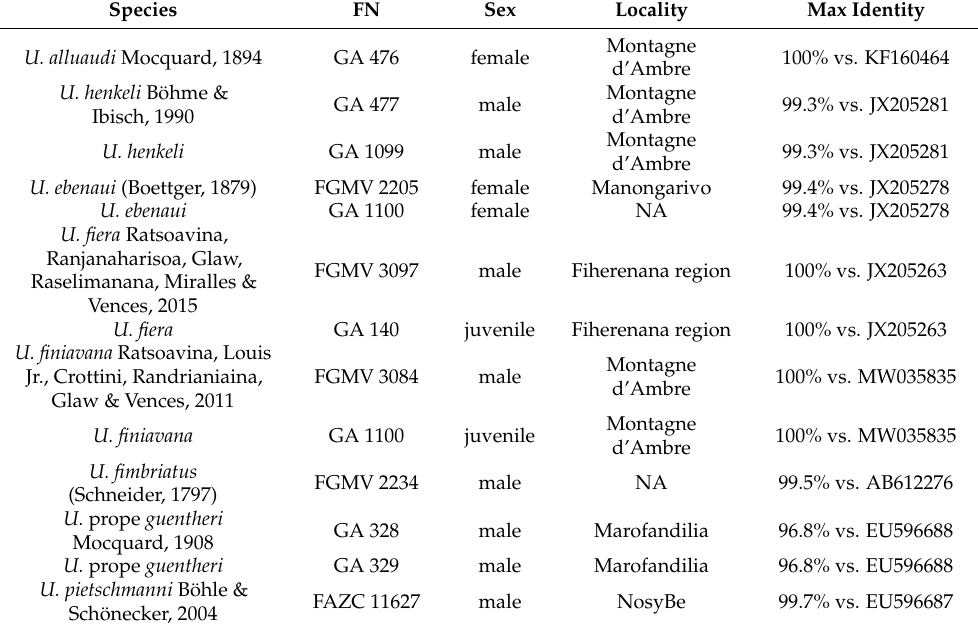
Table 1. Specimens analysed in this study. FN = field number. Max identity = Maximum identity scores with deposited homologous